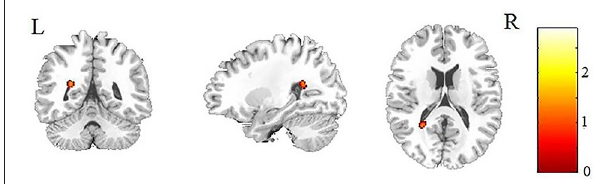
FIGURE 1 | Patients with IGE showed increased MD (refer to color scale) in the WM of the left splenium of the corpus callosum compared with healthy controls after AlphaSim correction ( P < 0.05). MD, mean diffusivity; WM, white matter.